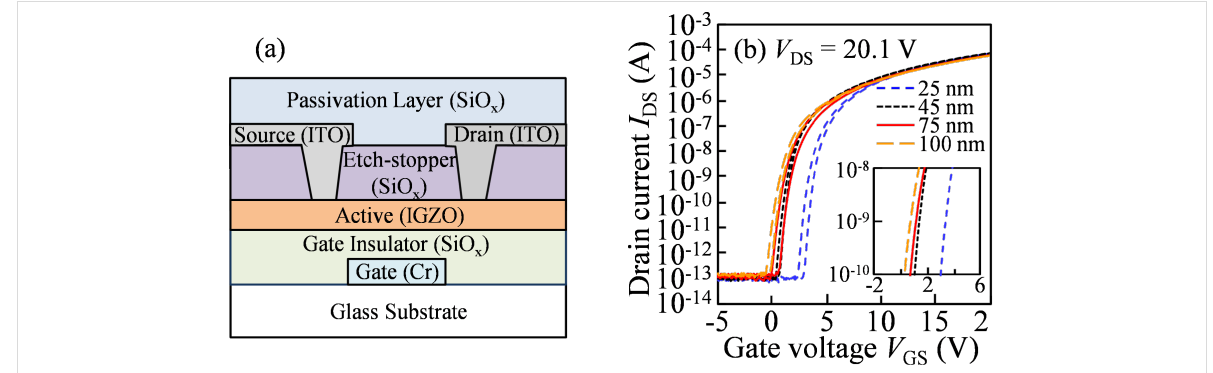
Figure 1: (a) Schematic cross-sectional view and (b) the initial transfer characteristics of a-IGZO TFTs with various active layer thicknesses ( T IGZO ) measured at V DS = 20.1